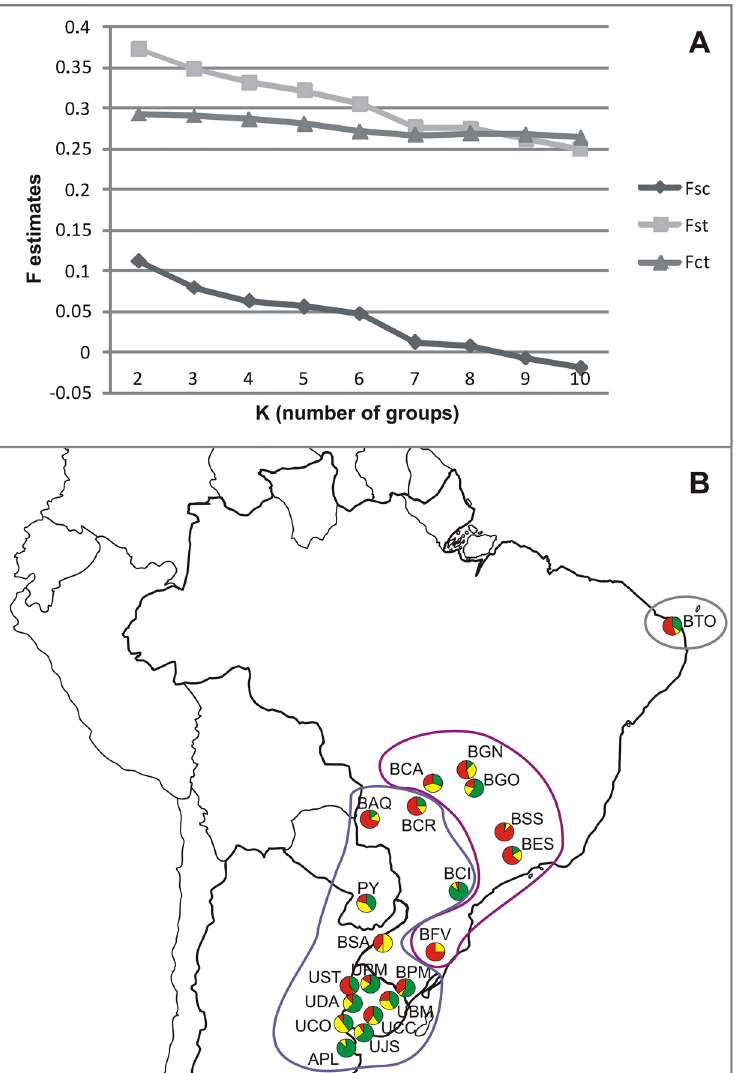
Fig 2. Structure analyses results for esterase data (K = 3). (A) SAMOVA F indices. F CT : differentiation between groups; F SC : differentiation between sampling locations within groups; F ST : differentiation between sites between groups. (B) Pie charts of the posterior probability to be from a group estimated by DAPC (i.e. Red, Yellow and Green) and SAMOVA grouping (i.e. I, II and III). SAMOVA groups (I, II and III), considered for posterior analyses, are defined by the grey, purple and blue